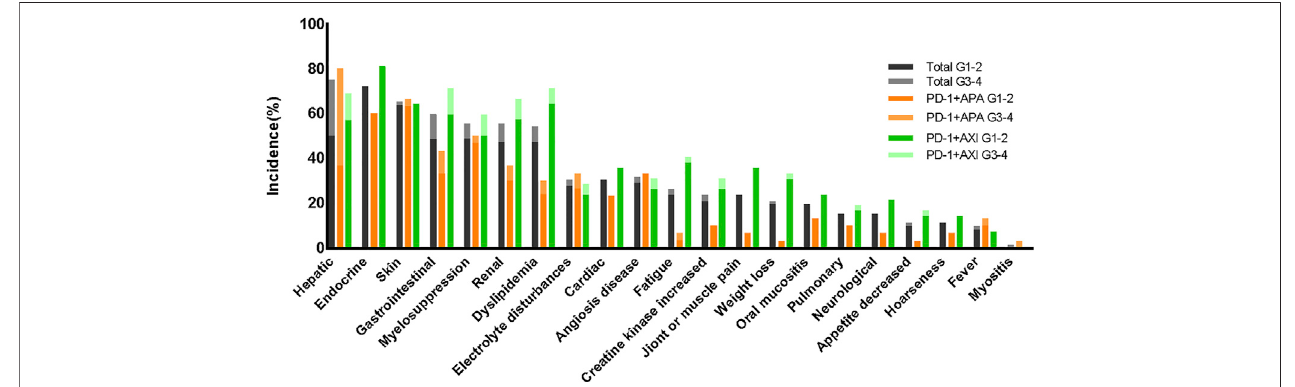
FIGURE 4 | Treatment-related adverse events between different therapeutic